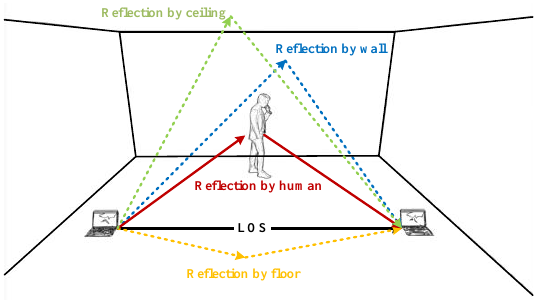
Figure 2. Wi-Fi sensing model.